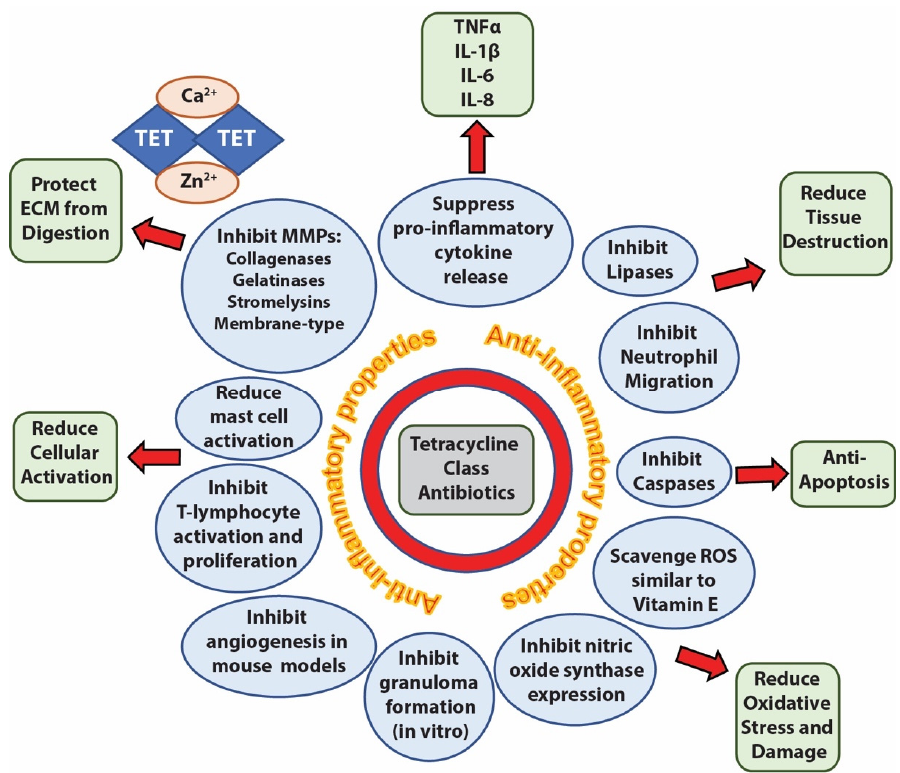
Figure 1. Anti-inflammatory properties of tetracycline class antibiotics. Tetracyclines (TET) can suppress, inhibit, or reduce multiple enzymatic, cellular, and signaling activities (blue circles) leading to protection of tissues from apoptosis, destruction, oxidation, stress, digestion or elevation of inflammatory cytokines (green boxes). One proposed mechanism for TET inhibition of matrix metalloproteinases (MMPs) is through chelation of divalent cations such as calcium (Ca 2+ ) and zinc (Zn 2+ ). Widespread use of broad-spectrum tetracyclines has had consequences for patients: emergence of antibiotic resistance among Cutibacterium acnes (pathogenic bacterium in acne vulgaris) and other bacterial species, increased perturbation of the gut microbiome leading to gut dysbiosis, and adverse events including gastrointestinal toxicity and ves- tibular side effects [2,8]. In the United States in 1983, 57% of C. acnes isolates from acne vulgaris patients were doxycycline-resistant; this is compared with 79% of C. acnes isolates being resistant to clindamycin and 81% resistant to erythromycin [9]. More recent data in the US is lacking, but in 2020, C. acnes isolates from acne vulgaris patients in Israel (mino- cycline 11%, tetracycline 8%, doxycycline 19%, clindamycin 17%, erythromycin 25%) and Jordan (minocycline 3%, tetracycline 36%, doxycycline 37%, clindamycin 56%, and eryth- romycin 73%) demonstrated substantial antibiotic resistance [10,11]. Similar resistance problems in C. acnes were observed in Japan [12]. These antimicrobial resistance (AMR) trends are supported by a systematic analysis on the global burden of AMR in 2019, which estimated 4.95 million worldwide deaths associated with bacterial AMR [13]. Even sub- antimicrobial dosing, a strategy commonly employed by dermatologists to reduce risk of AMR or adverse events during treatment of acne vulgaris or acne rosacea, is increasingly linked to multi-drug resistance [14–18]. The United States Healthcare Infection Control Practices Advisory Committee (HICPAC) and Centers for Disease Control (CDC) published in 2016 an “Antibiotic Stew- ardship Statement for Antibiotic Guidelines” [19]. The statement recommends physicians “discontinue or narrow unnecessarily broad-spectrum antibiotic therapy” as medically